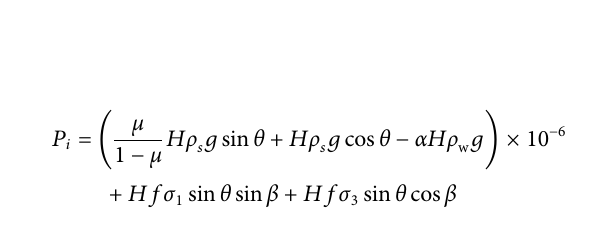
Frontiers in Earth Science |